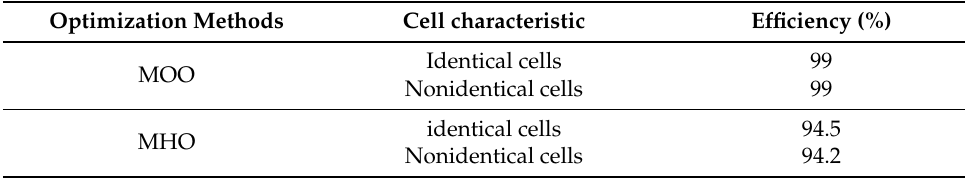
Table 2. Efficiency analysis of the proposed optimization methods. Optimization